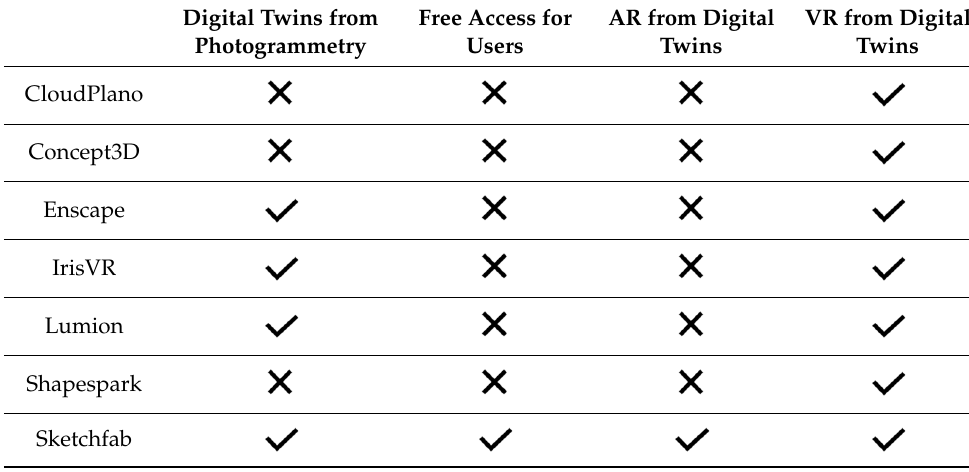
Table 6. Last selection of digital